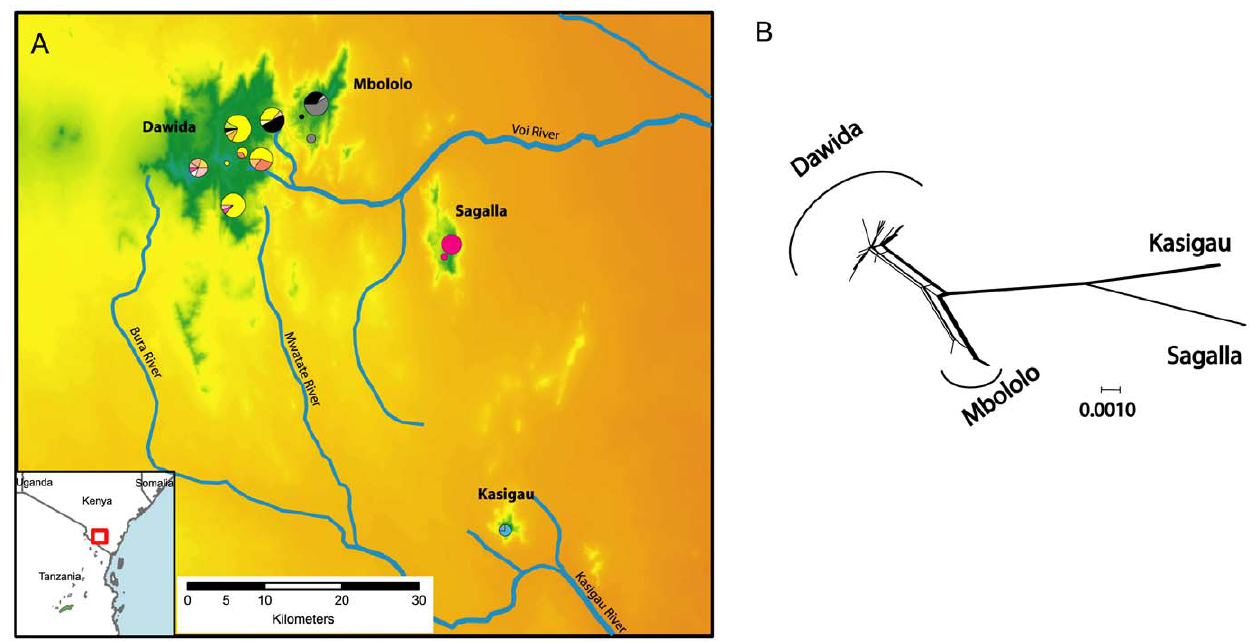
Figure 3. Sampling localities, haplotype frequencies and haplotype network for Kinyongiaboehmei from the Taita Hills, Kenya. A) The distribution of sampling localities within the Taita Hills, Kenya (inset). Topography is shown from green (highest) to orange (lowest) with major rivers labelled. Circles are proportional to number of individuals sampled and segments within the circles represent haplotypes. Note the presence of Mbololo haplotypes (black) in the northern areas of Dawida. B) ND2 network visualised using the NeighborNet algorithm with secondary contact omitted. Each line represents the connection between two haplotypes with the thicker lines representing many connections.